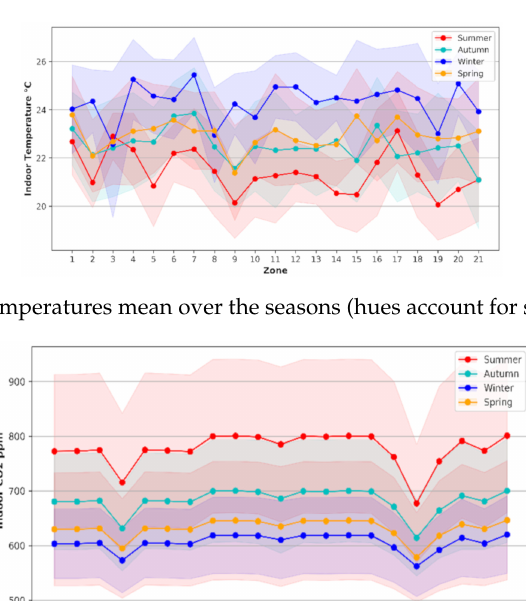
Figure 13. PMV mean over the seasons (hues account for standard deviation).